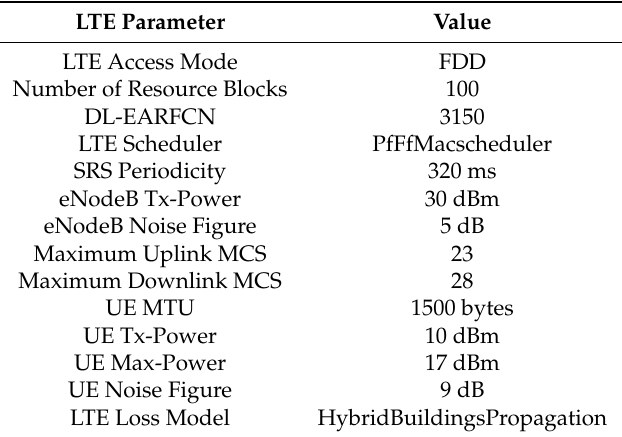
Table 1. LTE simulation